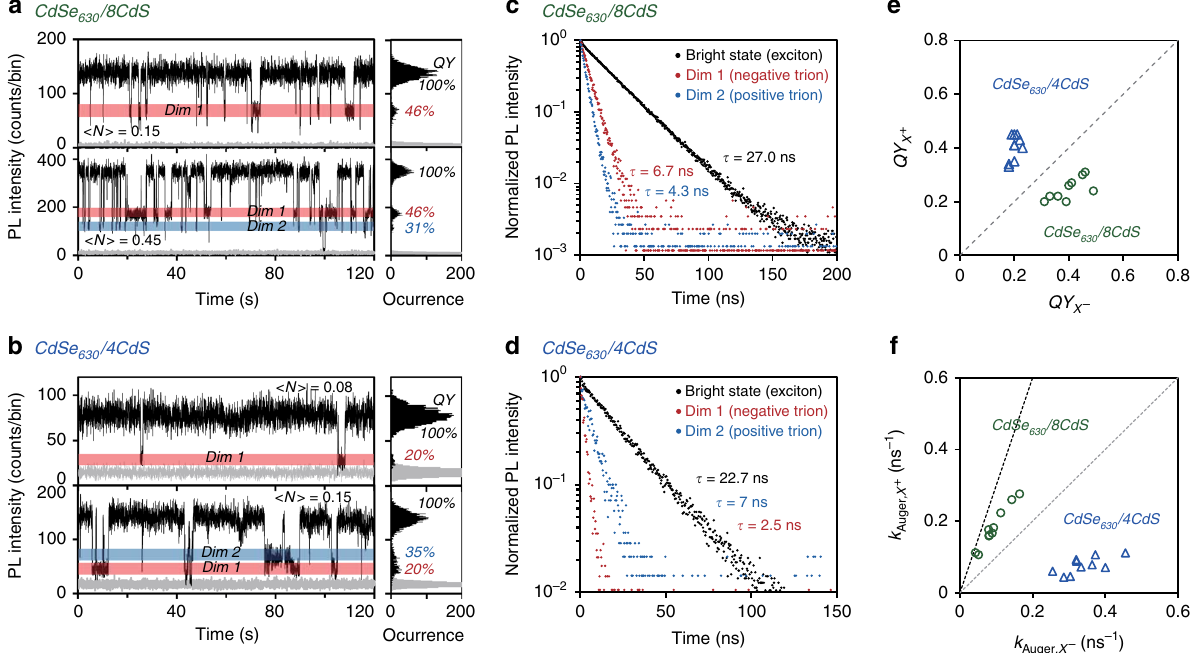
Fig. 4 Inversion of emission quantum ef fi ciency of negative and positive trions. a , b PL intensity trajectories and histograms for single CdSe 630 /8CdS and CdSe 630 /4CdS core/shell quantum dots (QDs). The two distinct dim states with different emission intensities are shaded in red ('Dim 1') and blue ('Dim 2'), which are corresponding to negative and positive trion states, respectively. c , d PL decay curves of the three emission states in a and b . e , f The plot of quantum yields (QYs) ( e ) and Auger rates ( f ) of positive trions versus those of negative trions for ten single CdSe630/8CdS (green circles) and CdSe630/4CdS (blue triangles) core/shell QDs . The dashed line (gray) in e represents QY X þ ¼ QY X (cid:2) . The gray and black dashed lines in f represent k k and k 3 k , Auger ; X þ ¼ Auger ; X (cid:2) Auger ; X þ ¼ Auger ; X (cid:2)